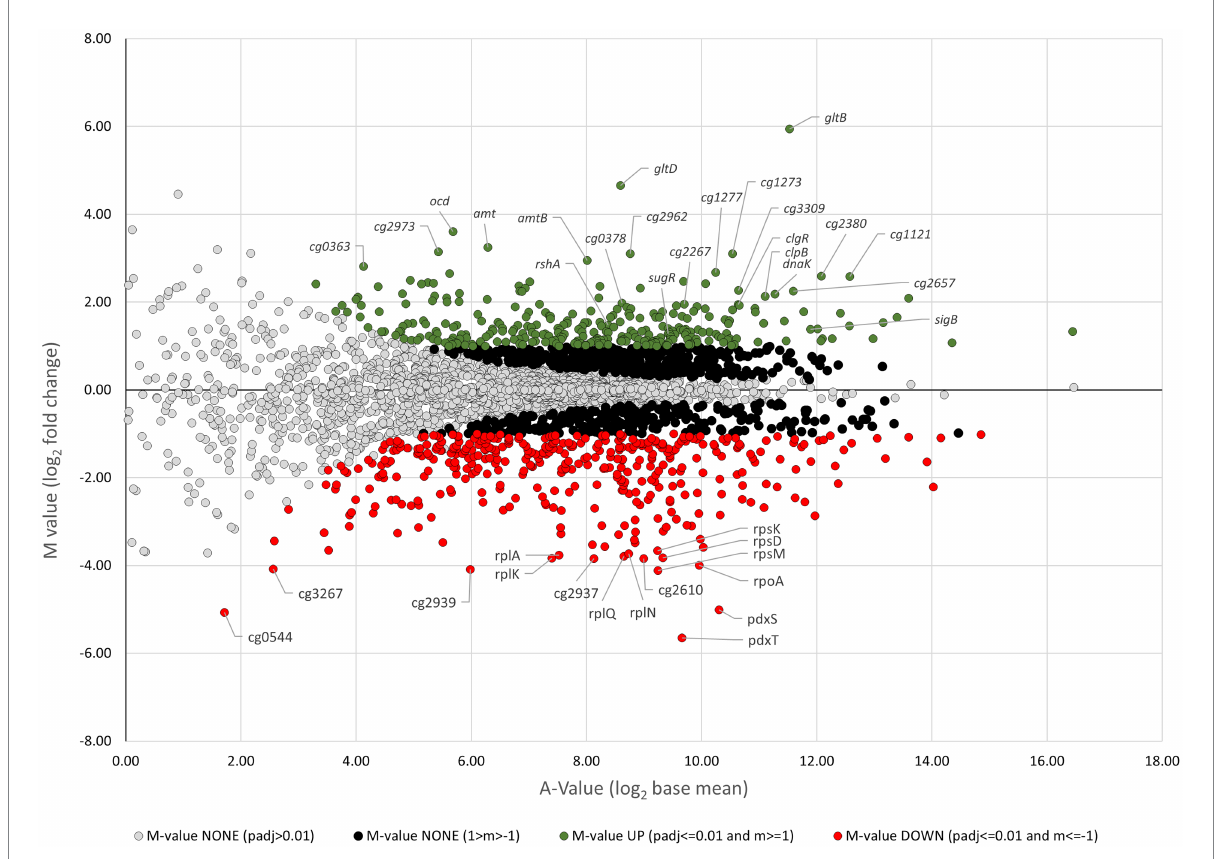
FIGURE 6 Ratio/intensity (M/A) plot derived from RNA-seq results comparing gene expression of the C. glutamicum Δ cseE strain with that of the C. glutamicum RES167 strain. The data were deduced from three RNA-seq analyses using total RNA probes from three biological replicates. Genes showing significantly increased or decreased transcription levels are marked with green and red circles, respectively. The A value represents the signal intensity, and the M value represents the signal intensity ratio, which corresponds to relative expression changes. The M value cutoff of 1 corresponds to relative expression changes equal to or greater than twofold. Genes were classified as being differentially expressed using the following cut-offs: M-value ≥ 1.0, upregulation; M-value ≤ − 1.0,